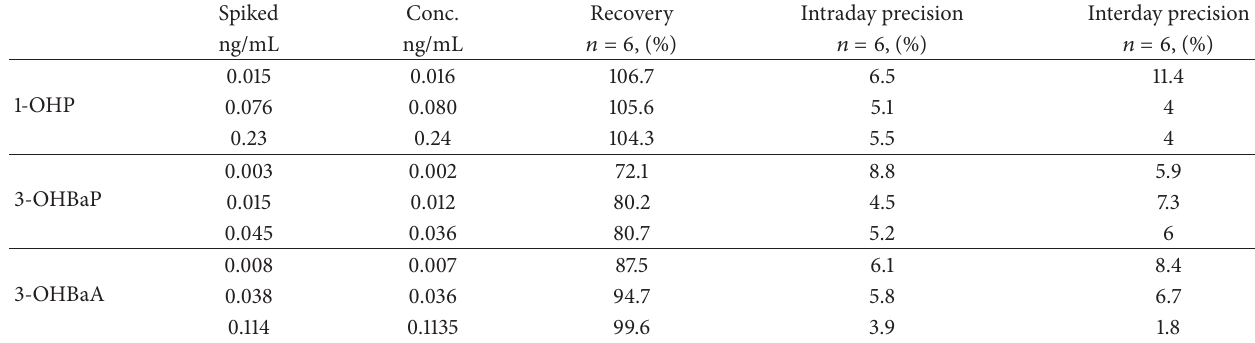
Table 2: Recovery and precision data for 1-OHP, 3-OHBaP, and 3-OHBaA.